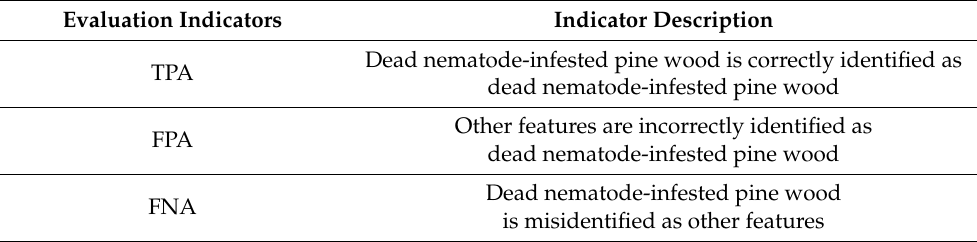
Table 2. The evaluation indicator table of target detection